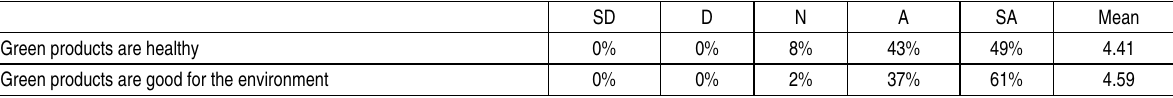
Table 5. Respondent perceptions of green